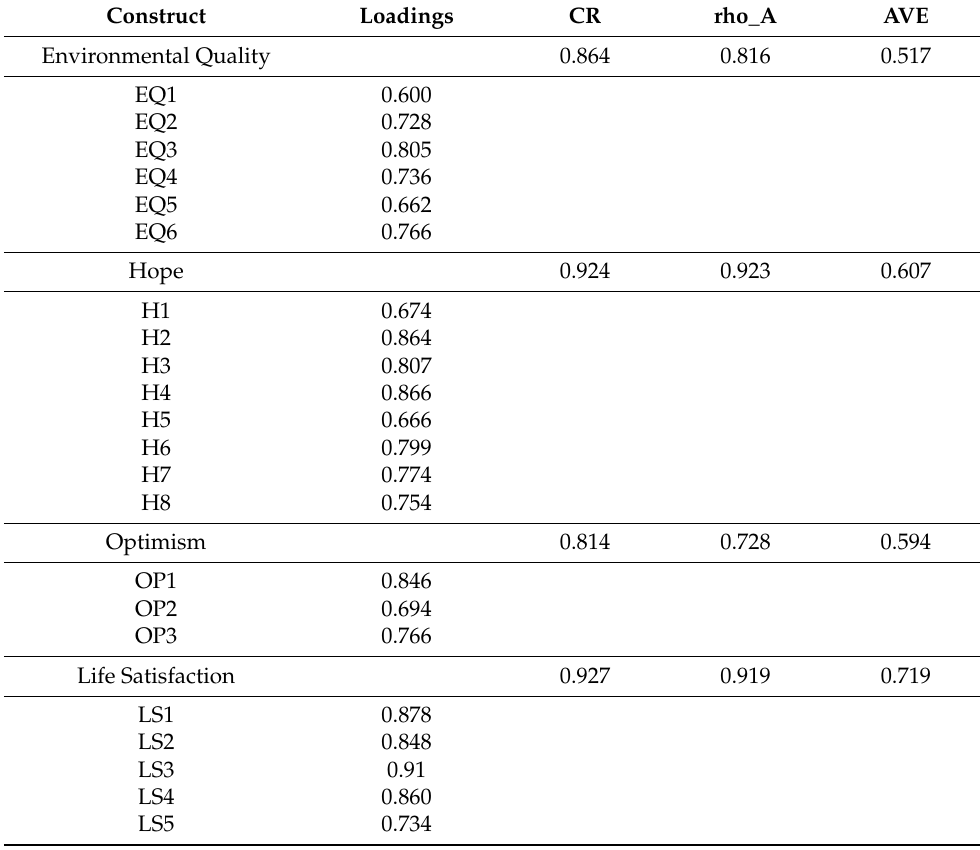
Table 2. Results of measurement model assessment.